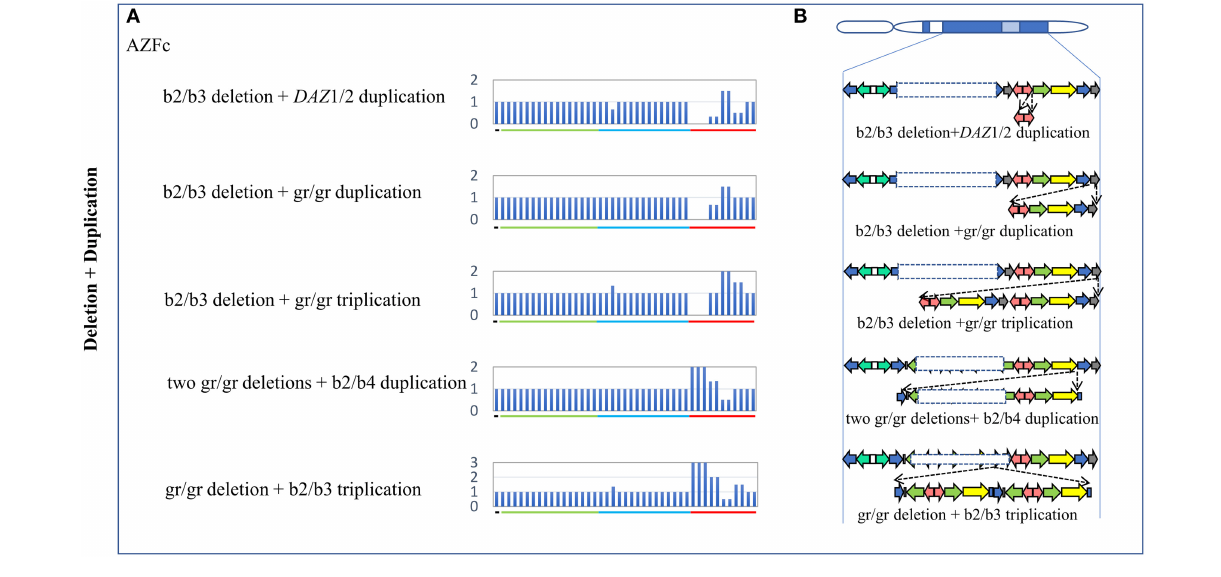
Frontiers in Genetics |